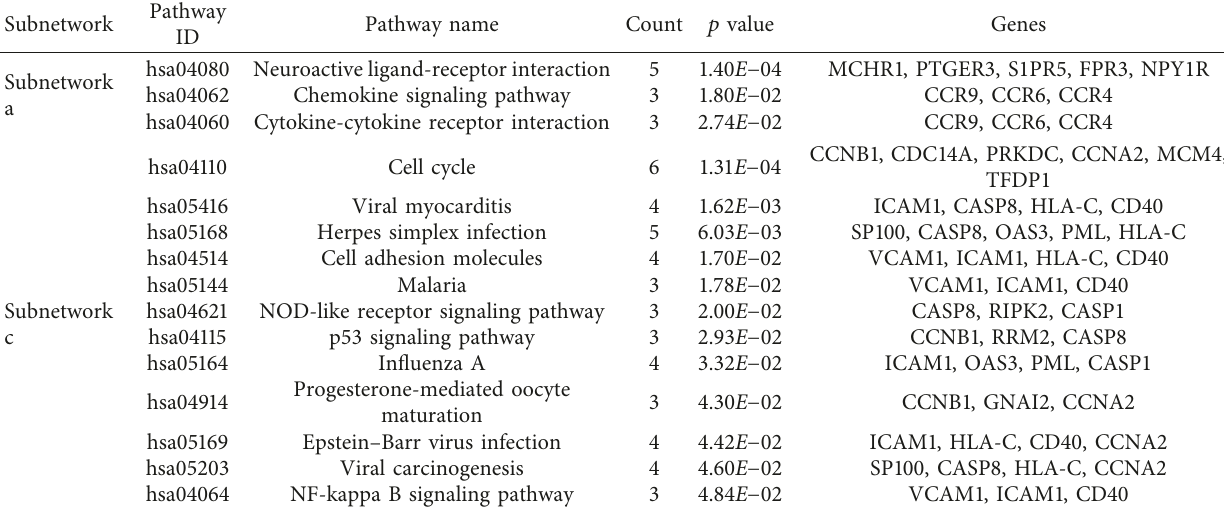
Table 2: List of KEGG pathways of subnetworks.